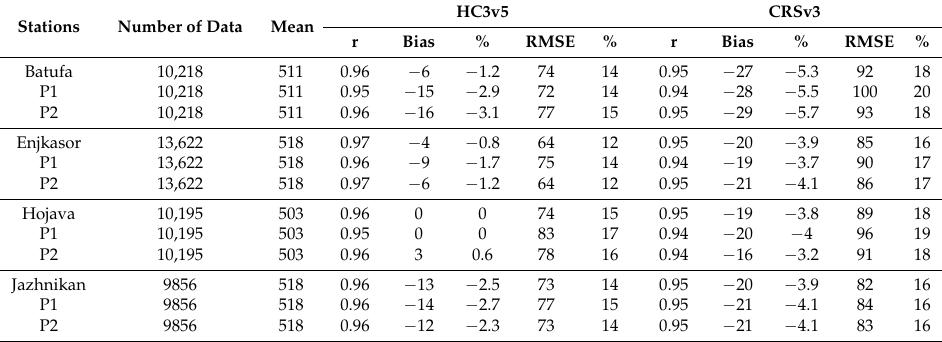
Table 3. Validation of hourly GHI under all-sky conditions for stations and points around them. Mean, bias and RMSE units are W/m 2 .